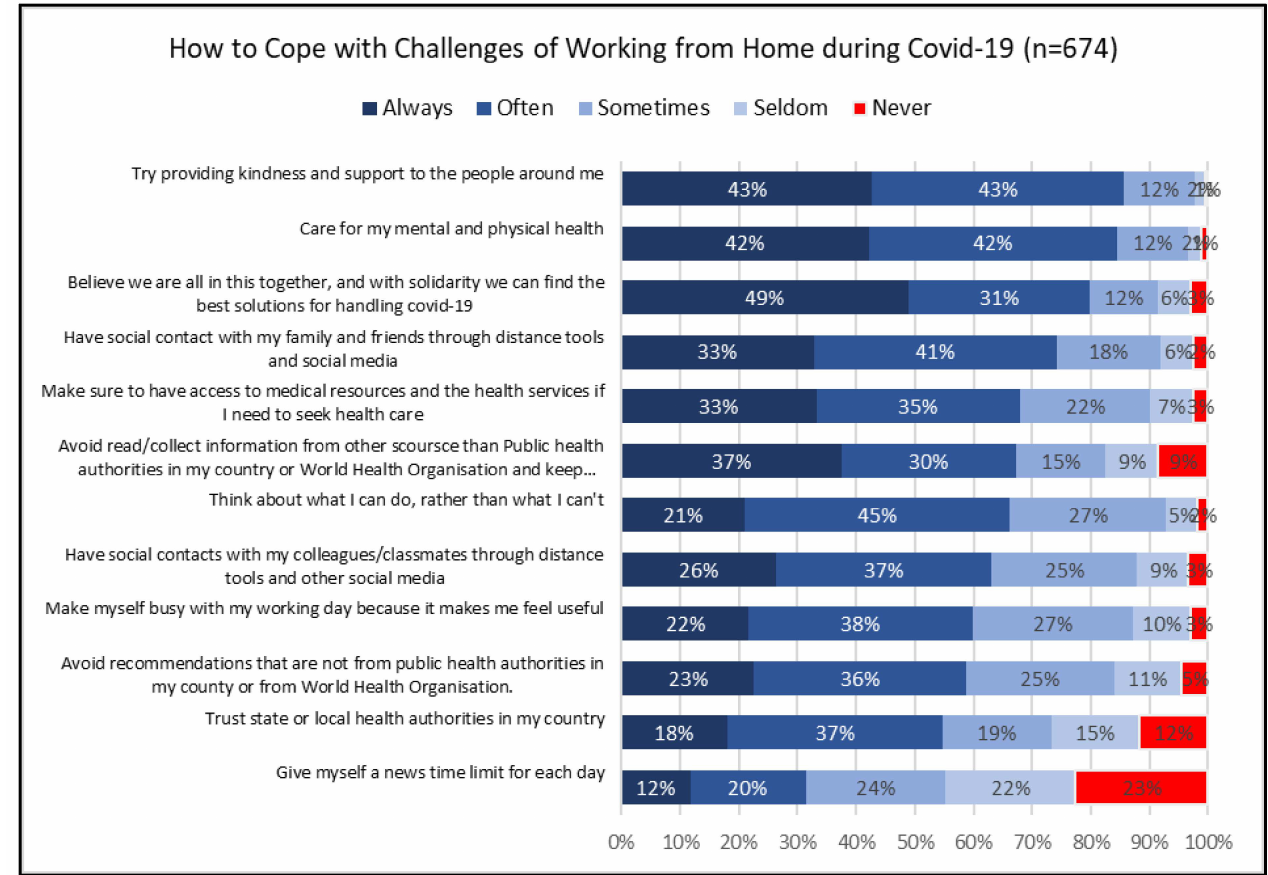
Figure 1. Methods of coping with challenges of working from